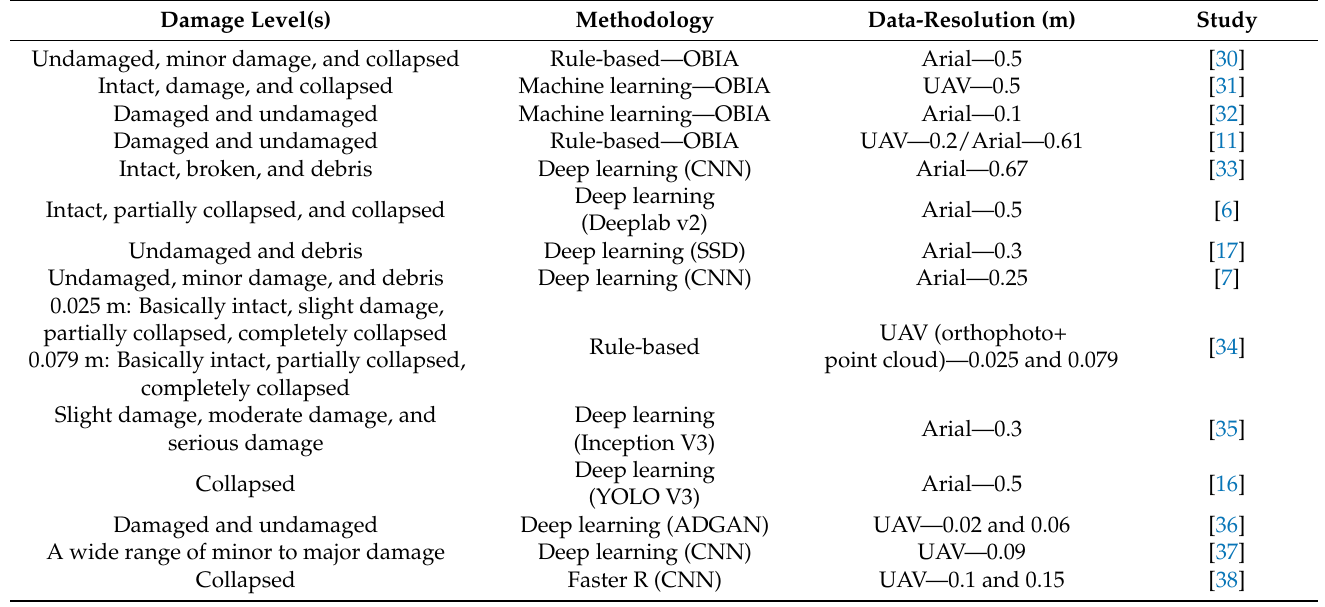
Table 1. Studies that have used UAV/aerial imagery to assess earthquake-induced damage, listed by